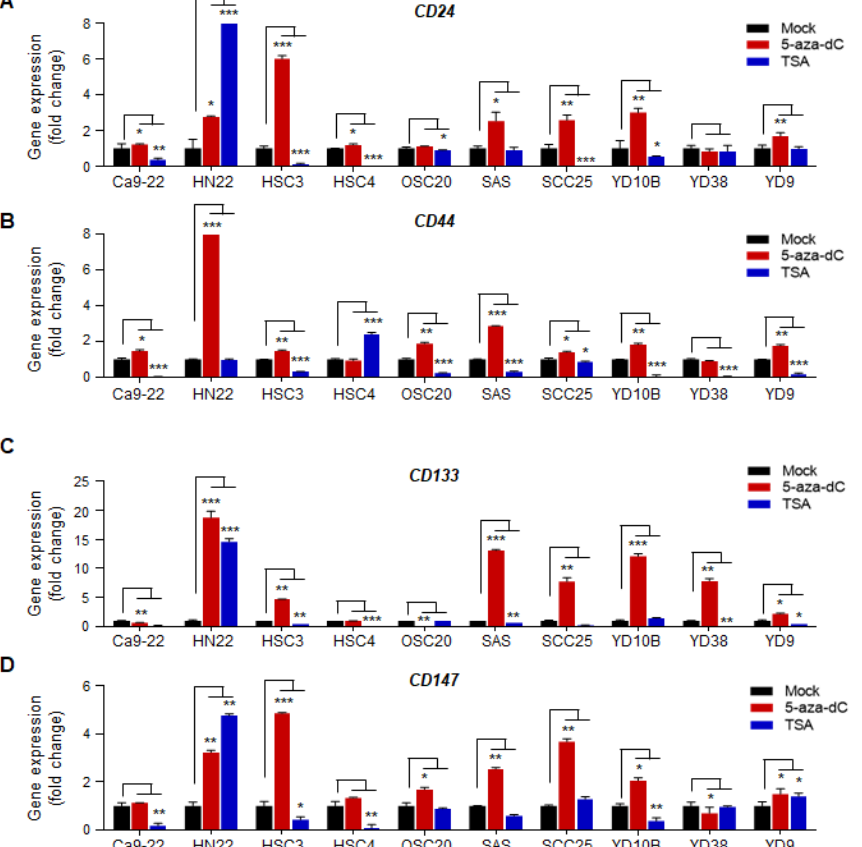
Figure 1. Epigenetic inactivation of CSC surface markers ( CD24 , CD44 , CD133 , and CD147 ) in OSCC cell lines. Quantitative real-time RT-PCR analysis was carried out to assess the transcriptional expression level of ( A ) CD24 , ( B ) CD44 , ( C ) CD133 , and ( D ) CD147 genes in OSCC cell lines before and after treatment with 5-aza-dC (5 µ M) for 72 h and TSA (0.3 µ M) for 18 h. The expression levels of the genes were internally normalized to the expression levels of GAPDH , and the normalized expression for each gene before 5-aza-dC treatments was set to one. The asterisks indicate significant increases in gene expression after 5-aza-dC treatment ( p < 0.05). All data were statistically analyzed using the Student’s t -test. * p < 0.05; ** p < 0.01; *** p < 0.001; no asterisk, not significant. A two-tailed Student’s t -test was used to compare data between the two